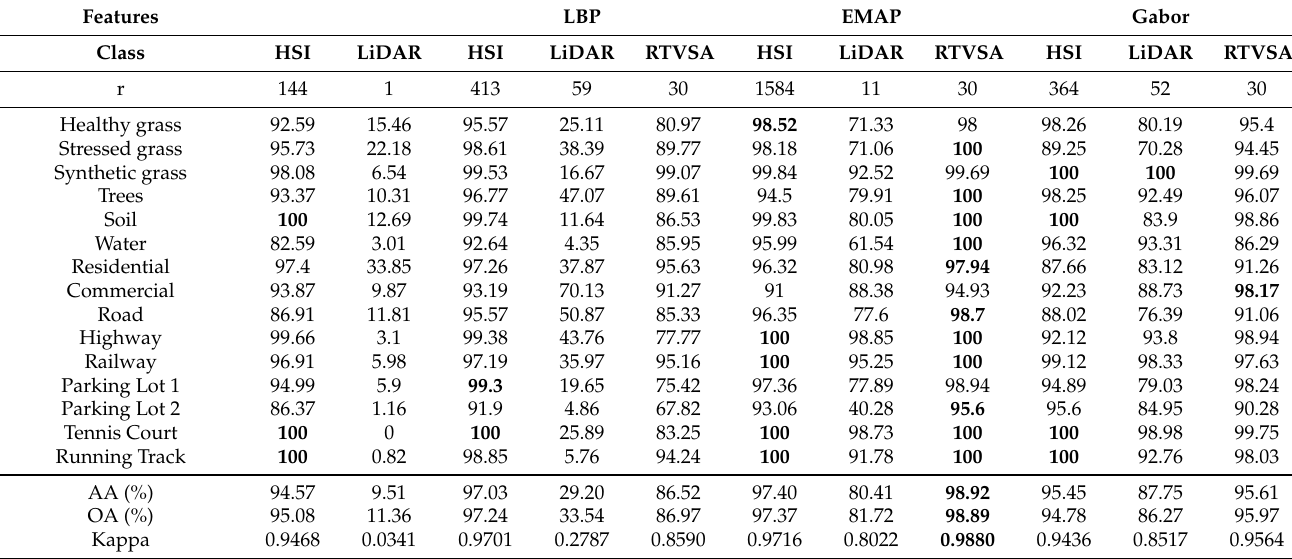
Table 3. The CNN classification performance of the proposed method based on the LBP, EMAP, and Gabor feature extraction on the 2012 Houston dataset (%). The best values are shown in bold. Features